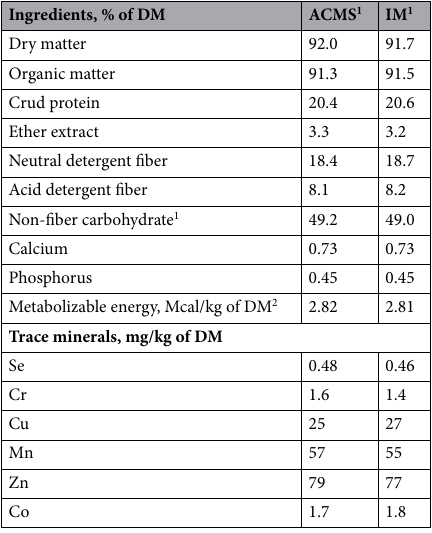
Table 3. Nutrients composition of ground starter feed. 1 IM inorganic minerals source, ACMS advanced chelated mineral source. 2 Estimated using NRC (2001) equations with the values from the analyses for